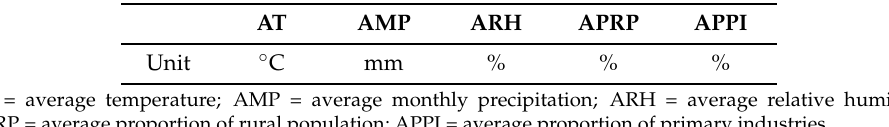
Table 1. Units of the variables.